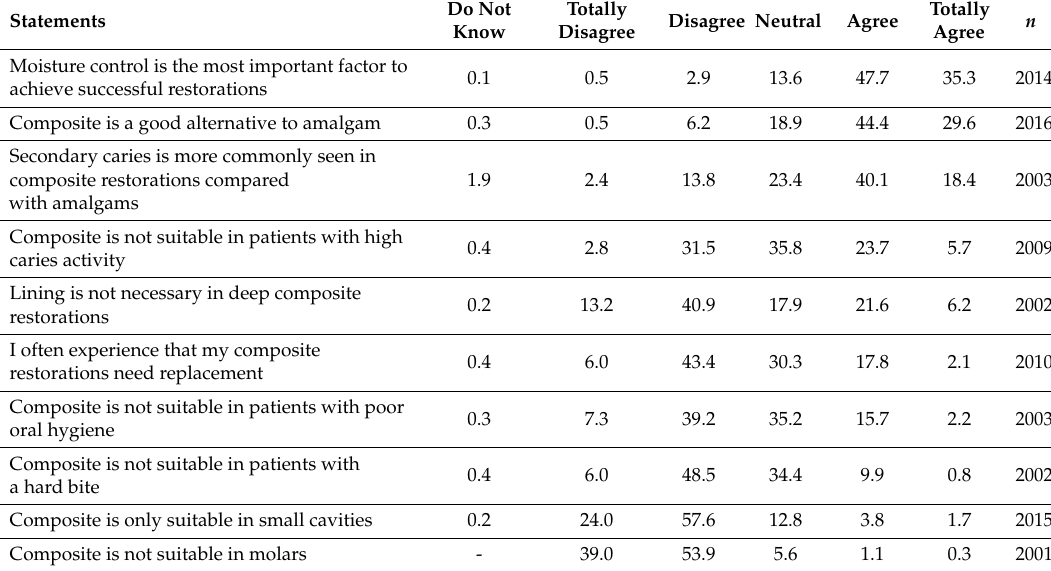
Table 4. Relate to the following statements regarding composite restorations